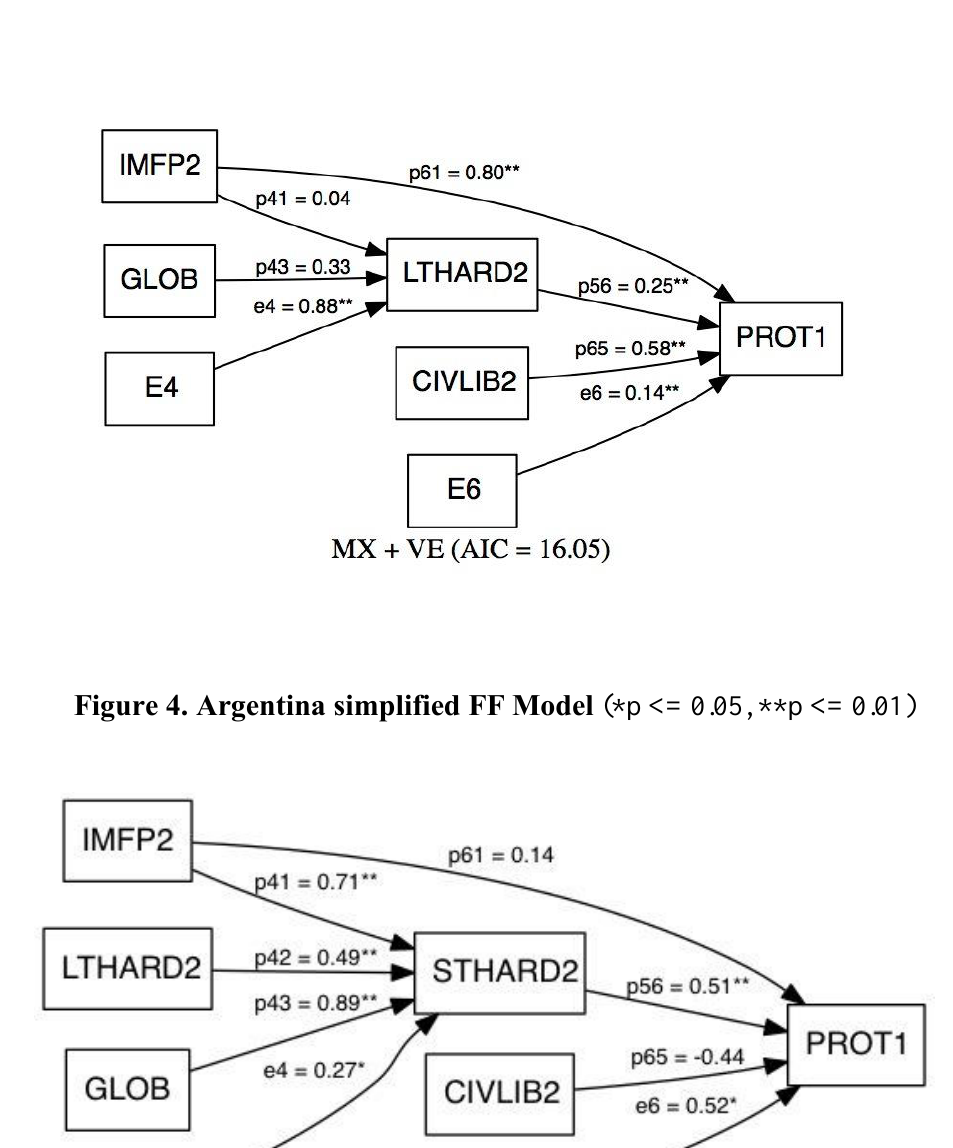
Figure 3. Best Multimodel, Mexico and Venezuela (*p <= 0.05, **p <= 0.01)